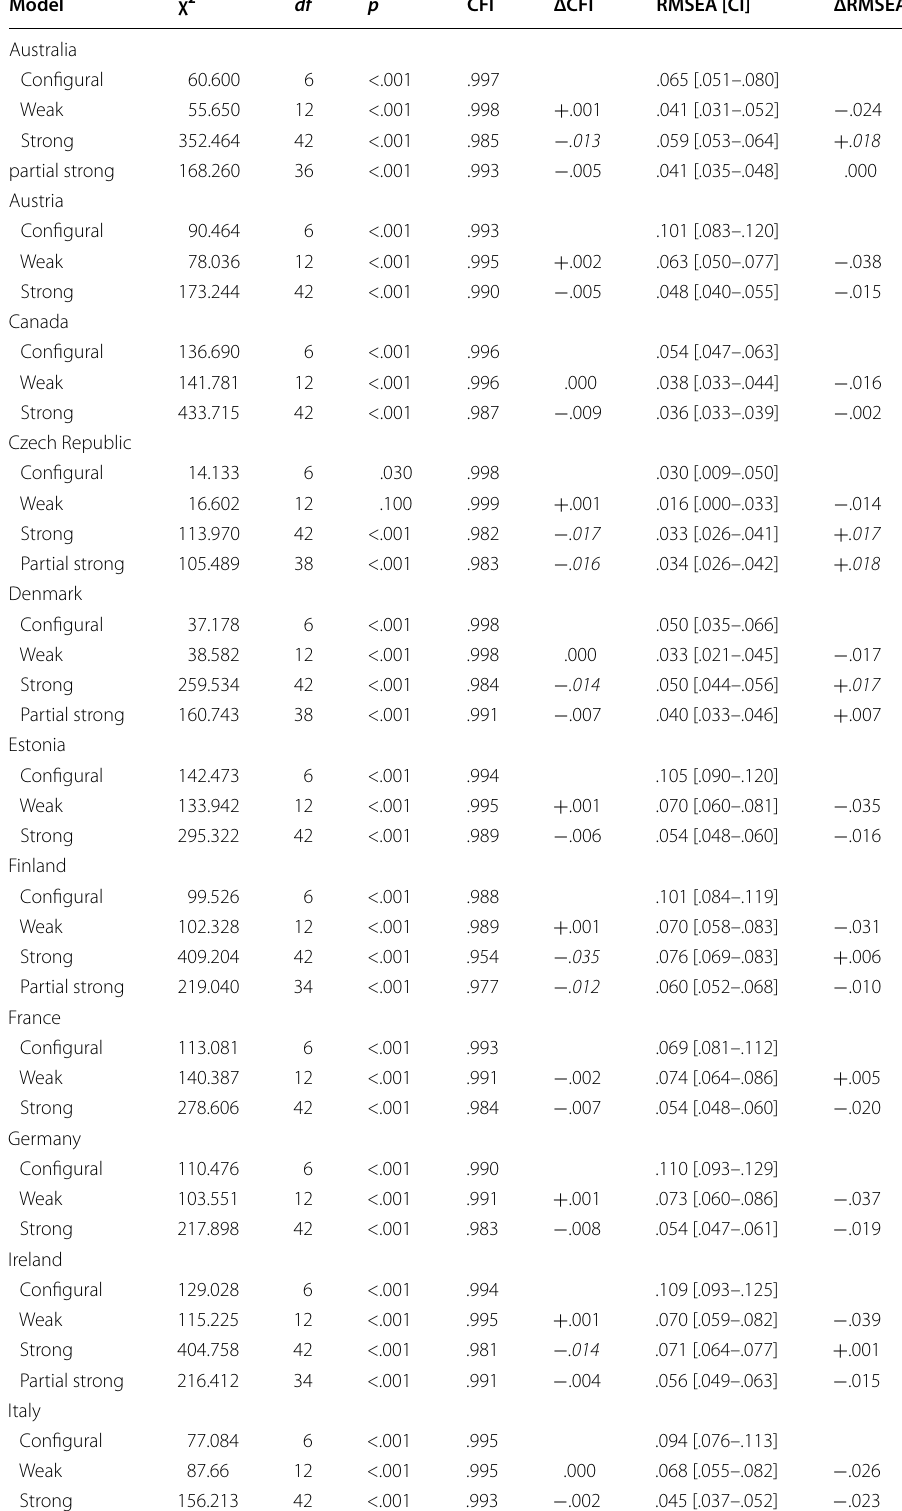
Table 5 Detailed model fit with level of education as grouping variable